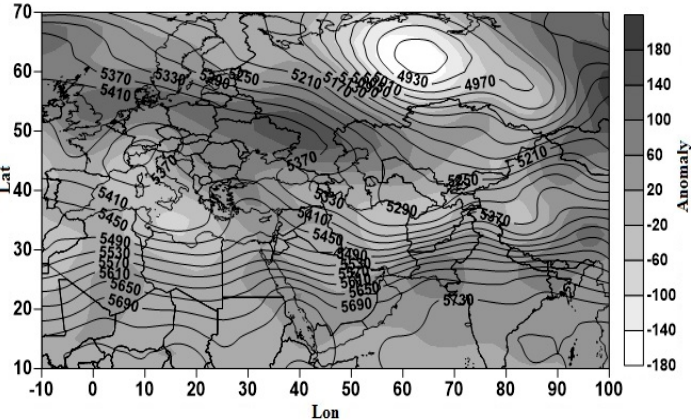
Figure 9. Anomalies and atmosphere thickness (in meters) for the representative day of the fourth pattern.